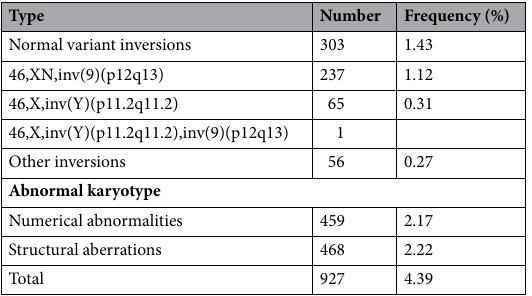
Table 1. Frequencies and types of chromosomal abnormalities in second trimester amniocentesis, N =